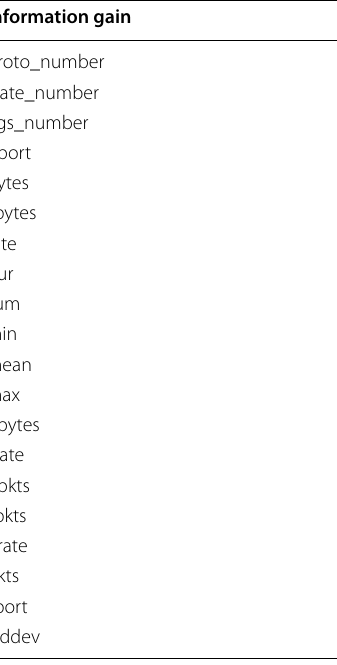
Table 48 Features by filter-based feature